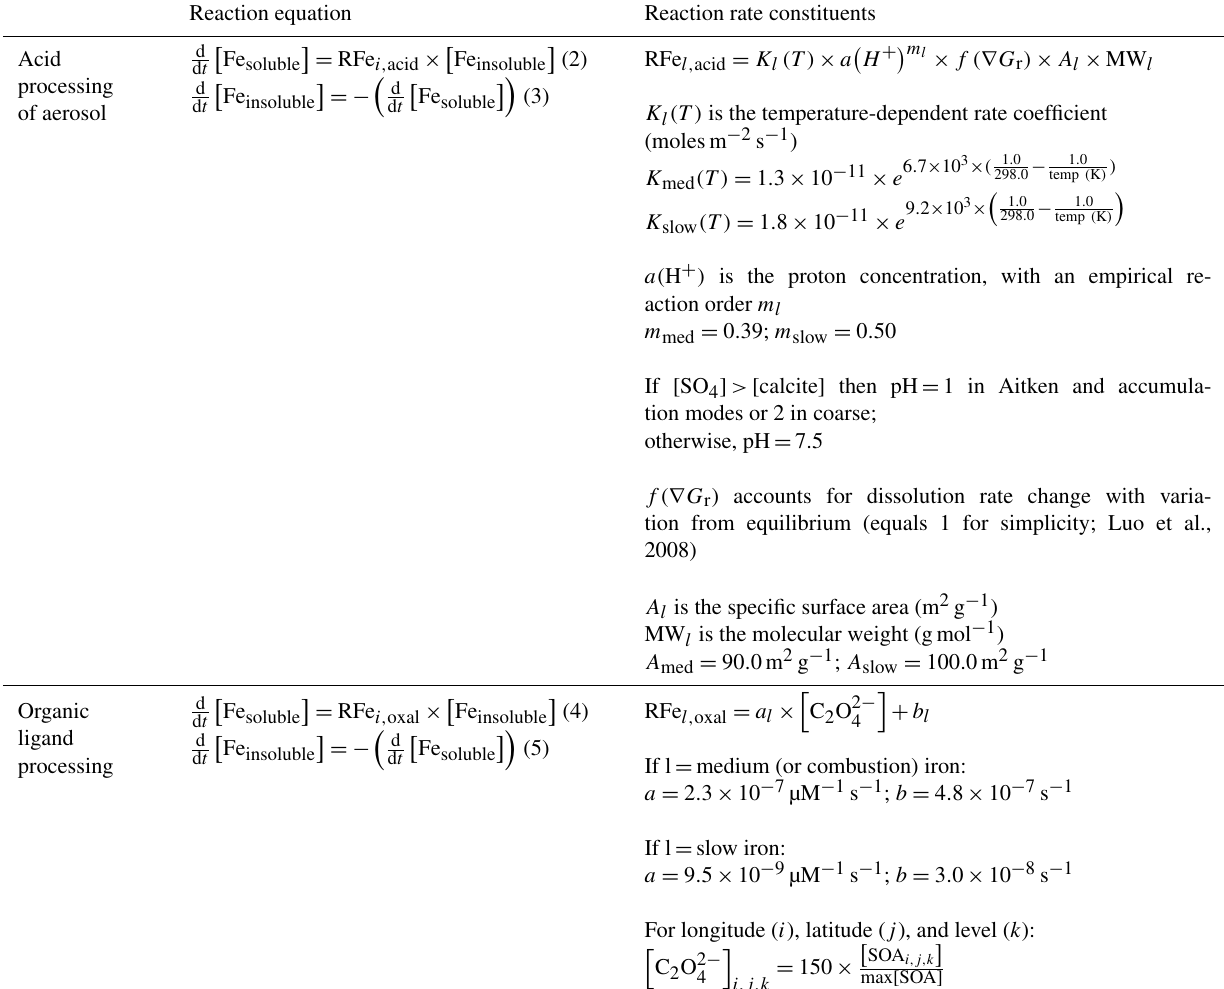
Table 5. Summary of atmospheric processing reaction equations from Scanza et al. (2018). Here l represents either medium- or slow-reacting iron aerosol (combustion iron is modelled as medium). The pH calculation is updated to be calculated within each mode, and oxalate (C 2 O 2 − concentrations are calculated based only on the secondary organic aerosol (SOA)